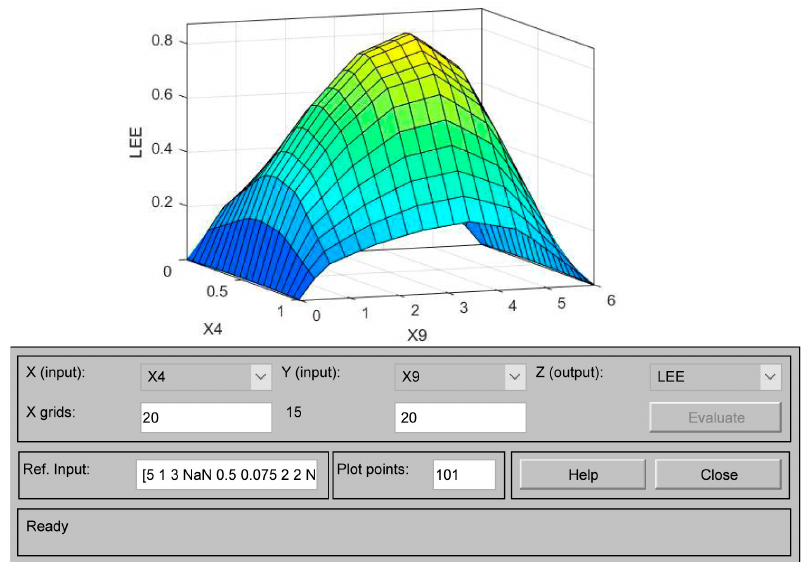
Figure 6. Dependence of LEE (x 4 ,x 9 ) on the degree of use of load capacity (x 4 ) and time interval (x 9 ) for vehicle of category N2.